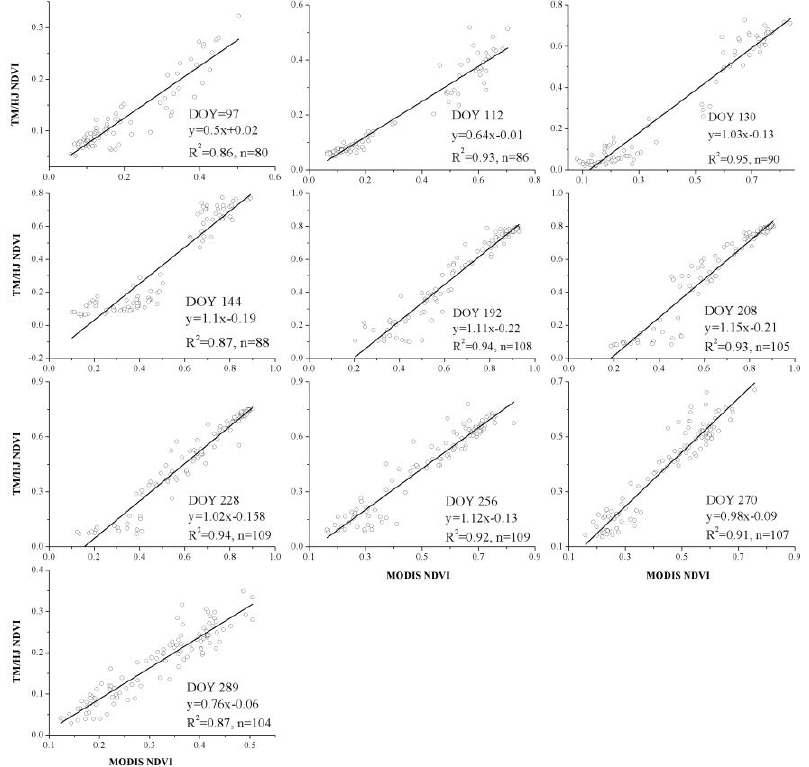
Figure 5. The relationship between the TM/HJ-CCD (NDVI calculated from the TM/HJ images) and the MODIS NDVI (NDVI calculated from the MODIS images) during the growing season for crops in Bole County during 2011. DOY, day of year; n, the number of samples used for the